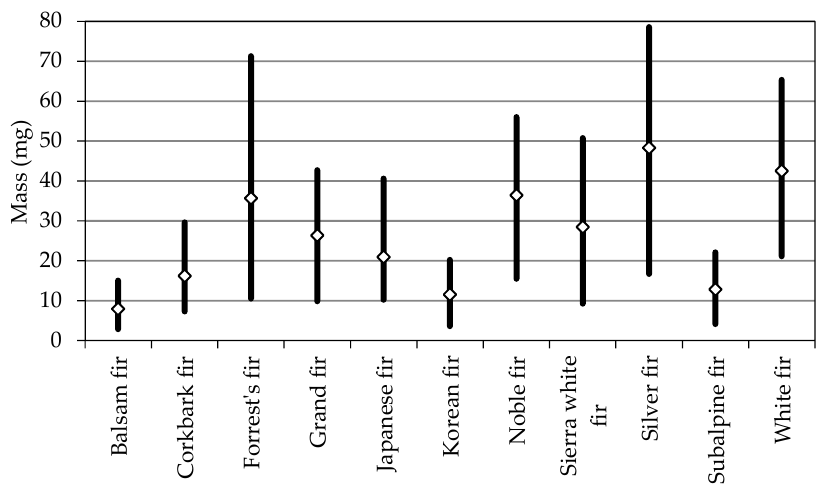
Figure 2. Range of variation in seed mass in selected fir species. Table 2. Mean values (± standard deviation) of the calculated indicators of seeds of selected fir species. Superscript letters denote significant differences between properties at p < 0.05 (Duncan’s test).